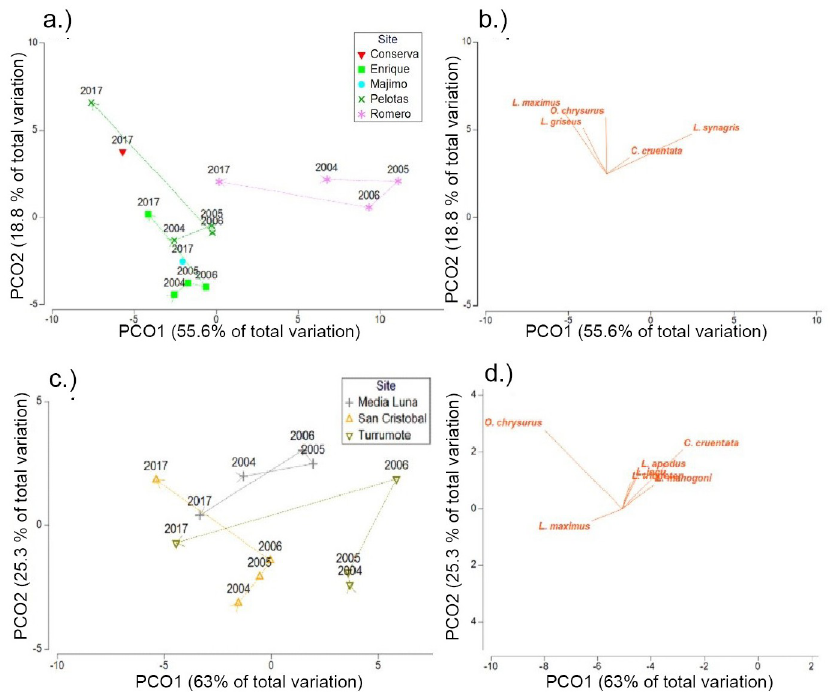
Fig 5. PCO plots showing density trajectories of the LPNR commercial assemblage from inshore and mid-shelf zones. Ordinations showing centroids of root-transformed commercial species density (fish/m 2 ) from LPNR by year from inshore sites (a) and mid-shelf sites (c). Adjacent plots (b, d) show corresponding response vectors (Pearson > 0.2) from top contributing species indicating direction and magnitude of contributions to dissimilarities between periods (2004–2006,